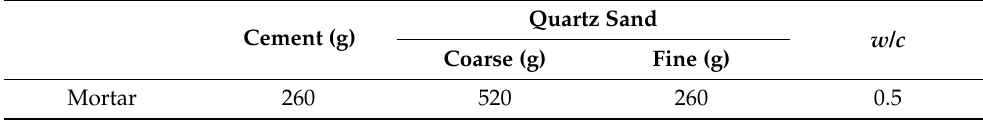
Table 4. Mixing ratios of the materials used for mortars.